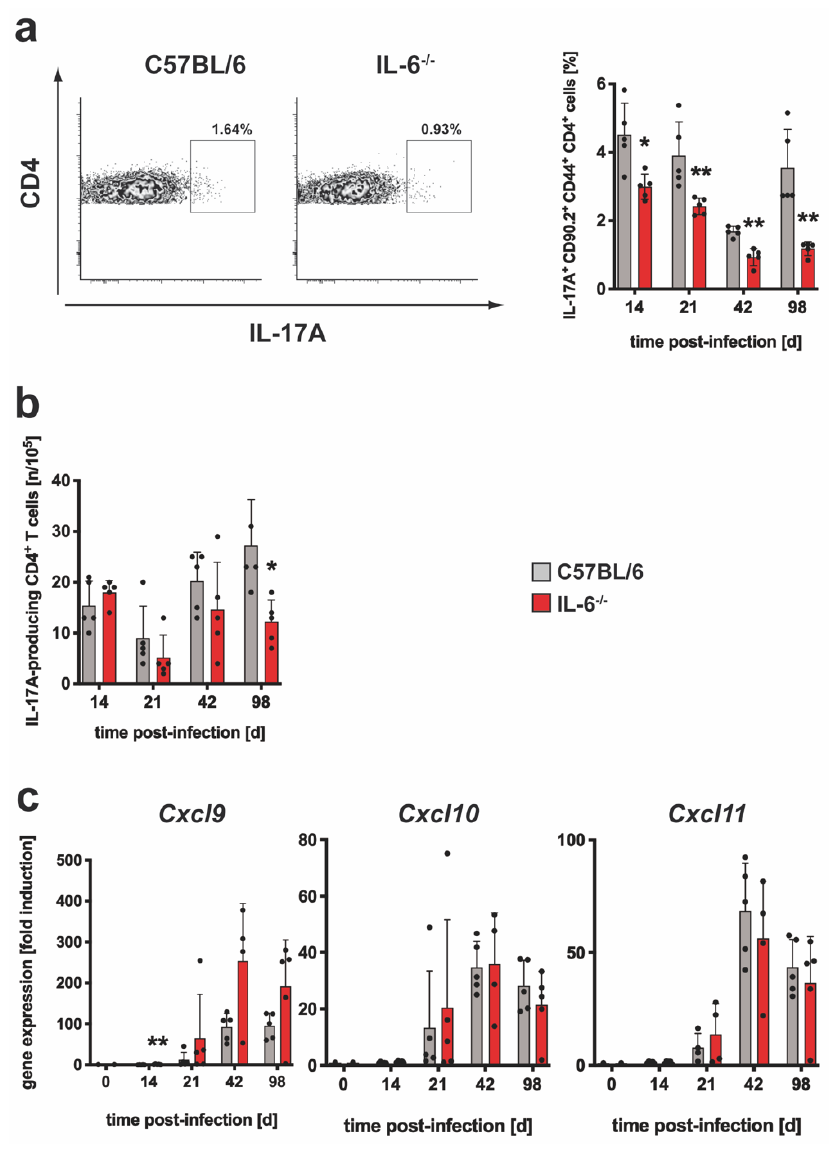
Figure 1. The TH17 immune response in IL-6 − / − mice during experimental TB. C57BL/6 (grey symbols) and IL-6 − / − (red symbols) mice were infected with approximately 100 CFU Mtb via the aerosol route. At the indicated time points, lungs were removed and further processed. ( a ) The relative amount of IL-17A-producing CD4 + CD44 + CD90.2 + T cells was determined in single cell suspensions of lungs by flow cytometry after restimulation with anti-CD3/CD28. Representative density plots of IL-17A-producing CD4 + CD44 + CD90.2 + T cells on day 42 and frequencies of IL-17A-producing CD4 + CD44 + CD90.2 + T cells during the course of infection are shown. ( b ) CD4 + T cells were purified from lung cell suspensions by MACS and restimulated with ESAT-6 1-20 . The frequency of IL-17A-producing cells was determined by ELISPOT. ( c ) After reverse transcription of isolated lung RNA, gene expression of Cxcl9 , Cxcl10 and Cxcl11 was quantified by real-time RT-PCR based on gene expression in uninfected mice. Mean values with standard deviations of 5 mice per group are shown. One representative experiment of two is shown. Data were statistically analyzed using the Mann–Whitney test defining differences between C57BL/6 and IL-6 − / − mice as significant (*, p ≤ 0.05; **, p ≤ 0.01).